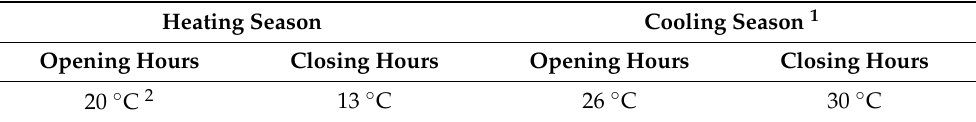
Table 4. Temperature set points [33].